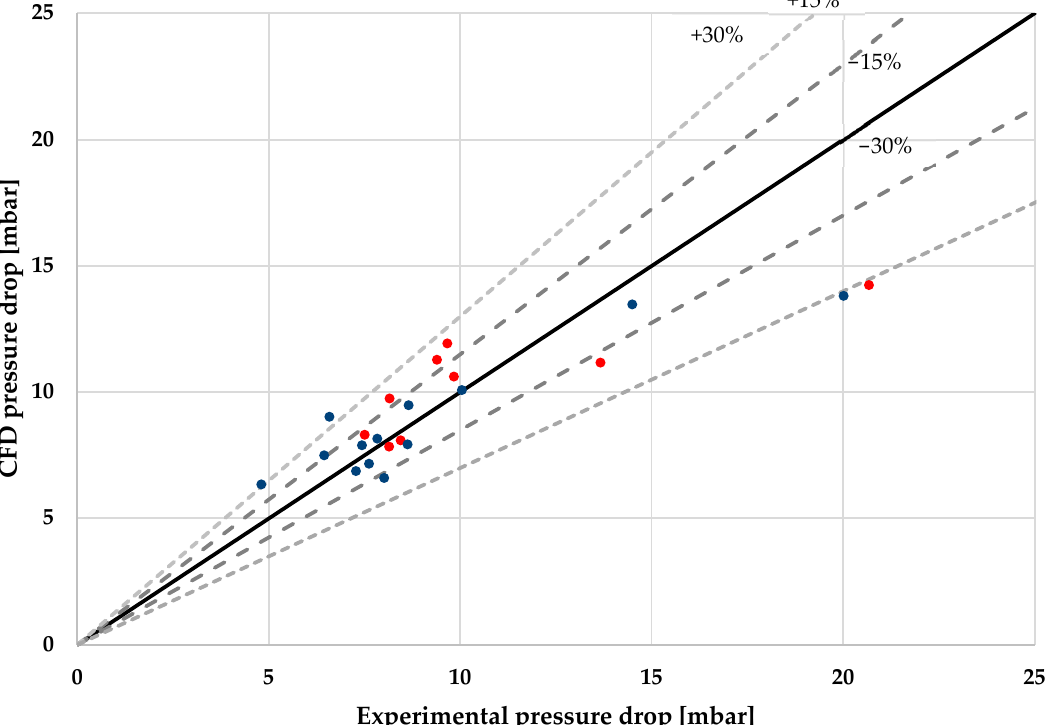
Figure 7. Multiphase experimental results vs. CFD on the proposed model. The red points correspond to the experiments of Table 6, while the blue points correspond to experiments where evaporation was not completed.